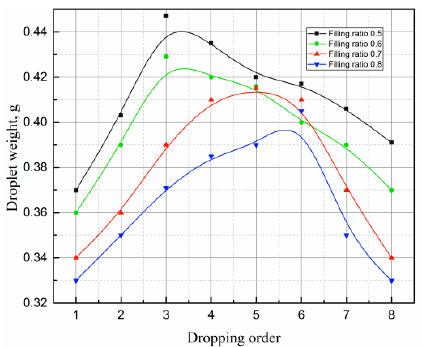
Figure 17. Variation of droplet weight at different filling rates in the physical simulation.